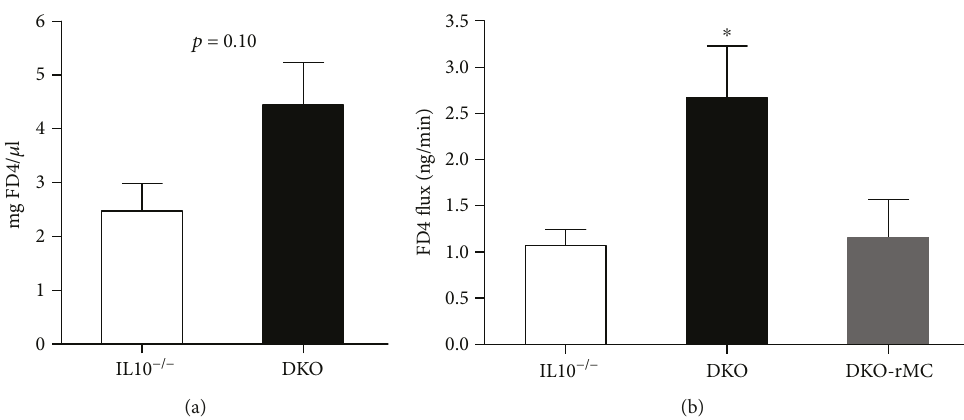
Figure 3: DKO mice have increased intestinal permeability that is ameliorated by reconstitution of bone marrow-derived mast cells. (a) In vivo intestinal permeability in IL10 − / − and DKO mice ( n = 3 – 5 per group). (b) FD4 permeability across distal colonic mucosa mounted on Ussing chambers. IL10 − / − : n = 23 ; DKO: n = 24 ; DKO-R IL10 − / − : n = 10 . ∗ p < 0 05 .